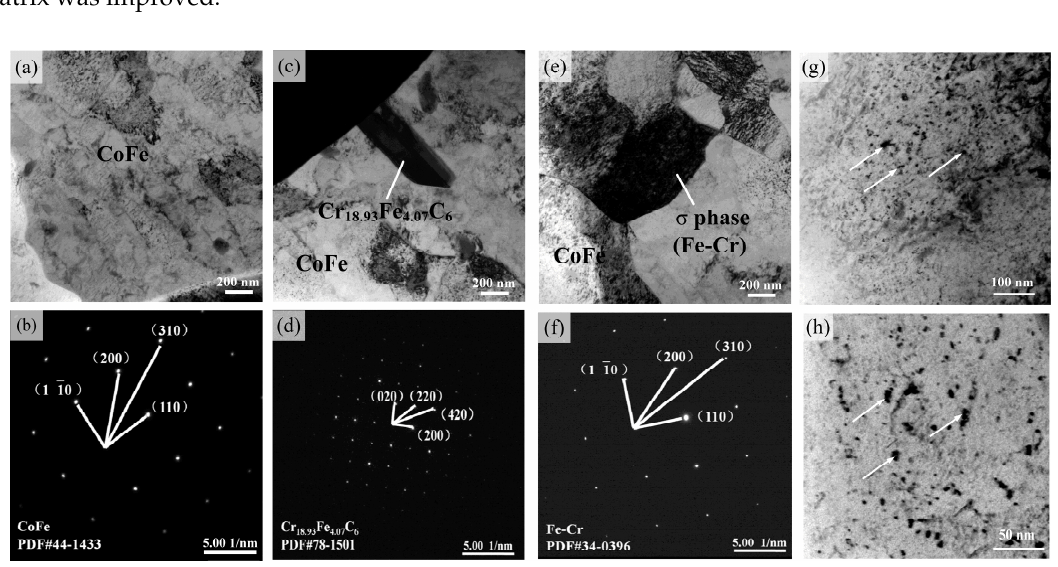
Figure 6. Element distribution perpendicular to fusion line of samples #1 and #2.